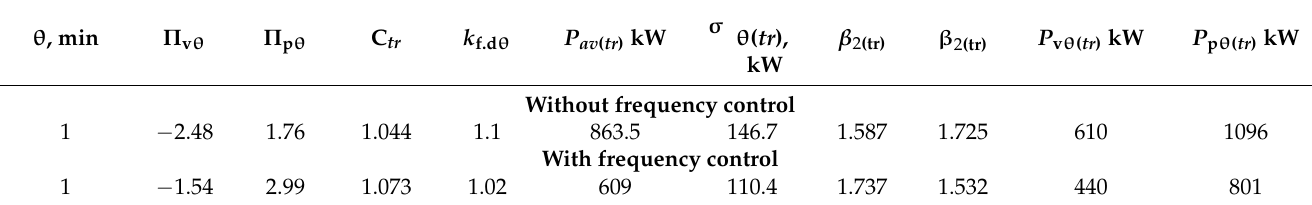
Table 16. Calculated values of the limits of change of ordinates, taking into account the truncation by the upper and lower